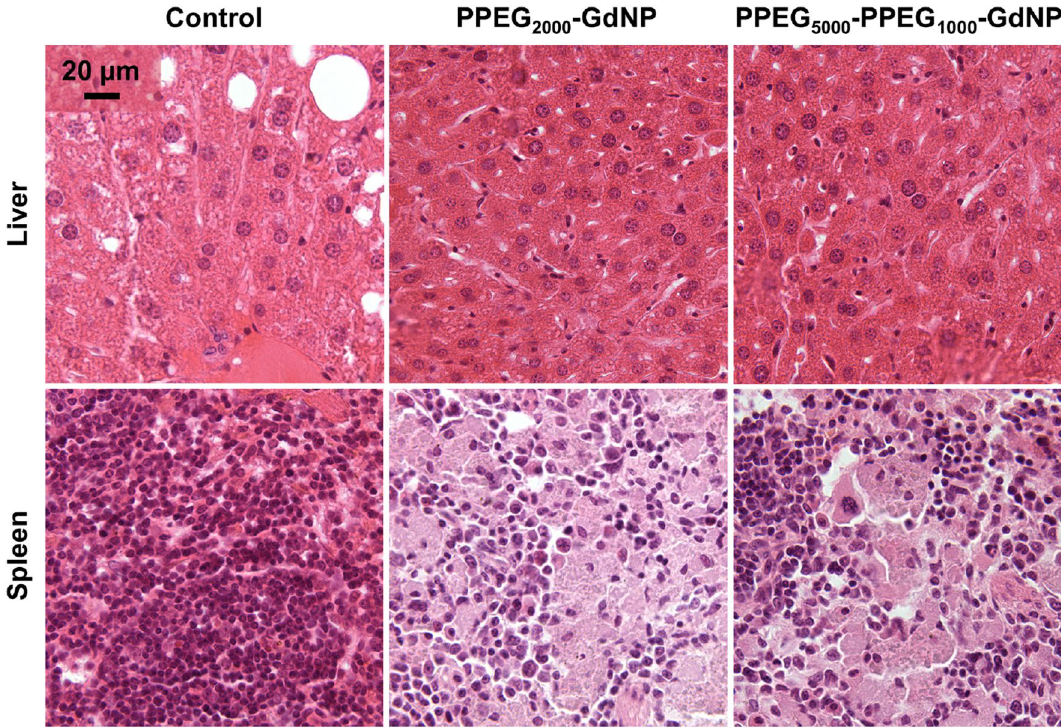
Figure 7. Representative histology images for control and injected mice taken from tissues after 5 days of injection. The scale bar in the liver control section applies to all images. Liver tissues appear normal, while the spleen tissues of the injected mice indicate basophilic nuclear contents in the cytoplasm and lower nuclear densities than the control